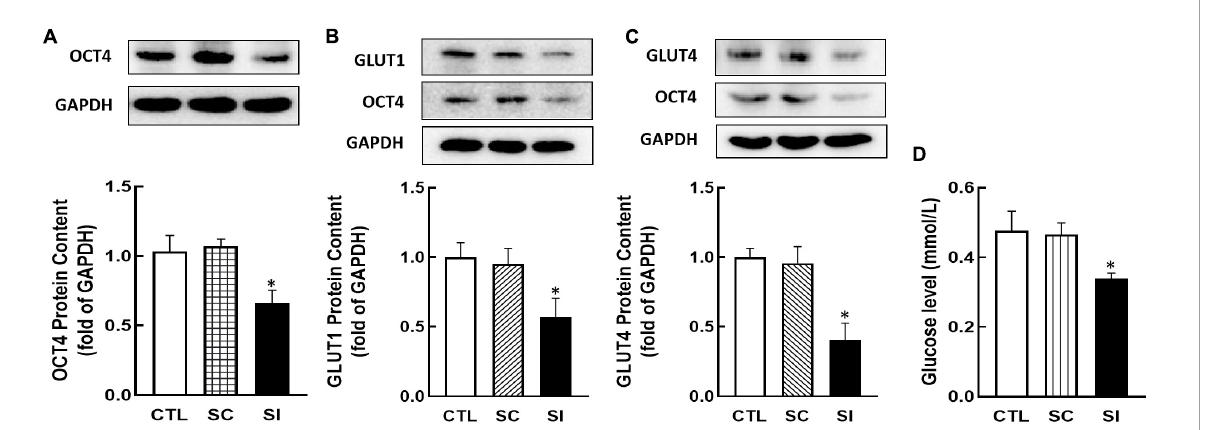
FIGURE5 Effect of Oct4 siRNA on GLUT1/4 expression and glucose uptake in KGN cells. The protein contents of OCT4 (A) , GLUT1 (B) , GLUT4 (C) , and glucose uptake (D) were detected by Western blot analysis or by 2-DG measurement after the cells were transfected with Oct4 siRNA (100 nM) for 48 h. Data are presented as mean ± SEM of three independent experiments. ∗ P < 0.05 compared with CTL.